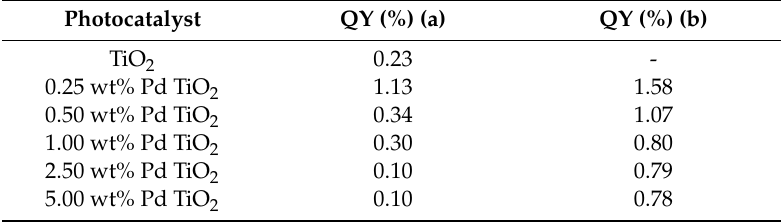
Table 7. QYs% for Pd-TiO 2 Photocatalysts at Di ff erent Metal Loadings (0.25, 0.50, 1.00, 2.50, and 5.00 wt%) under: (a) Visible light irradiation only, (b) Using near-UV light followed by visible light